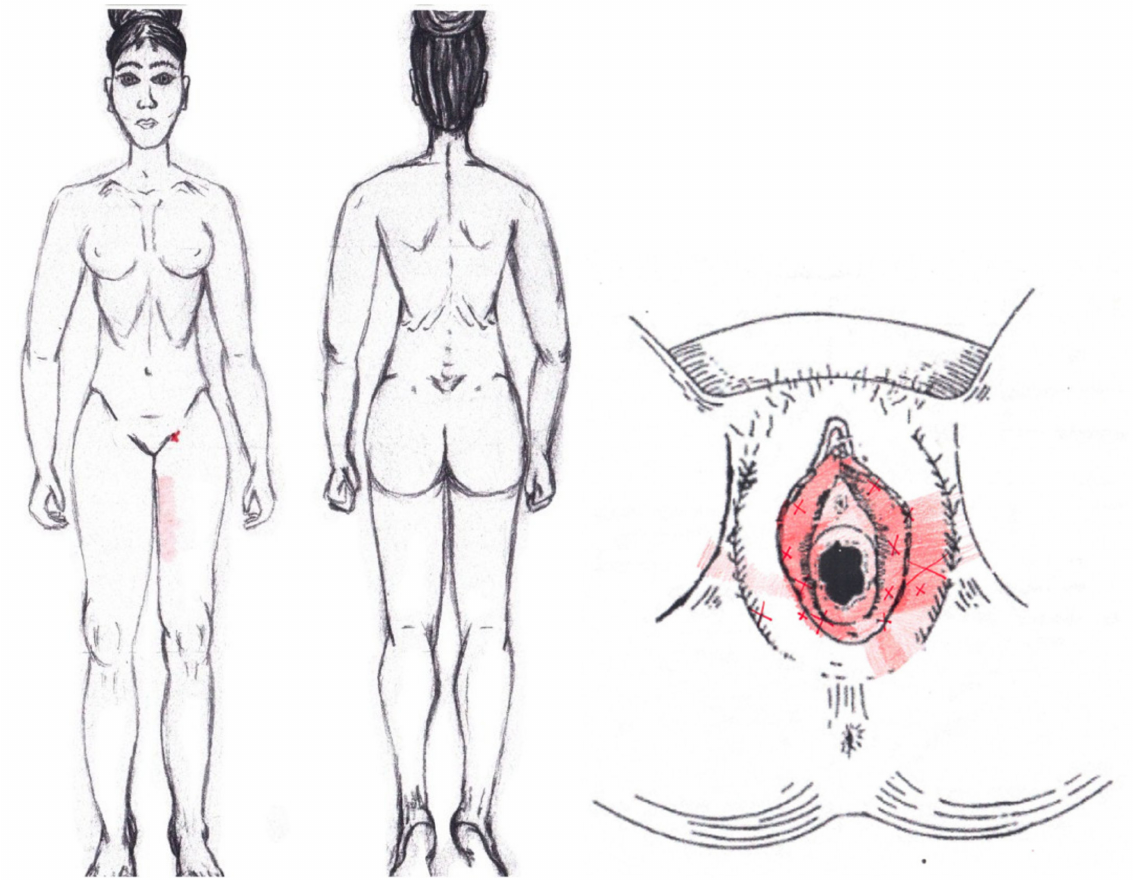
Figure 13. Graphical simulation of referred pain areas of the bulbospongiosus muscle. The frequency at the areas of referred bulbospongiosus muscle pain in the menstrual phase and in the ovulatory phase is shown in Tables 11 and 12,